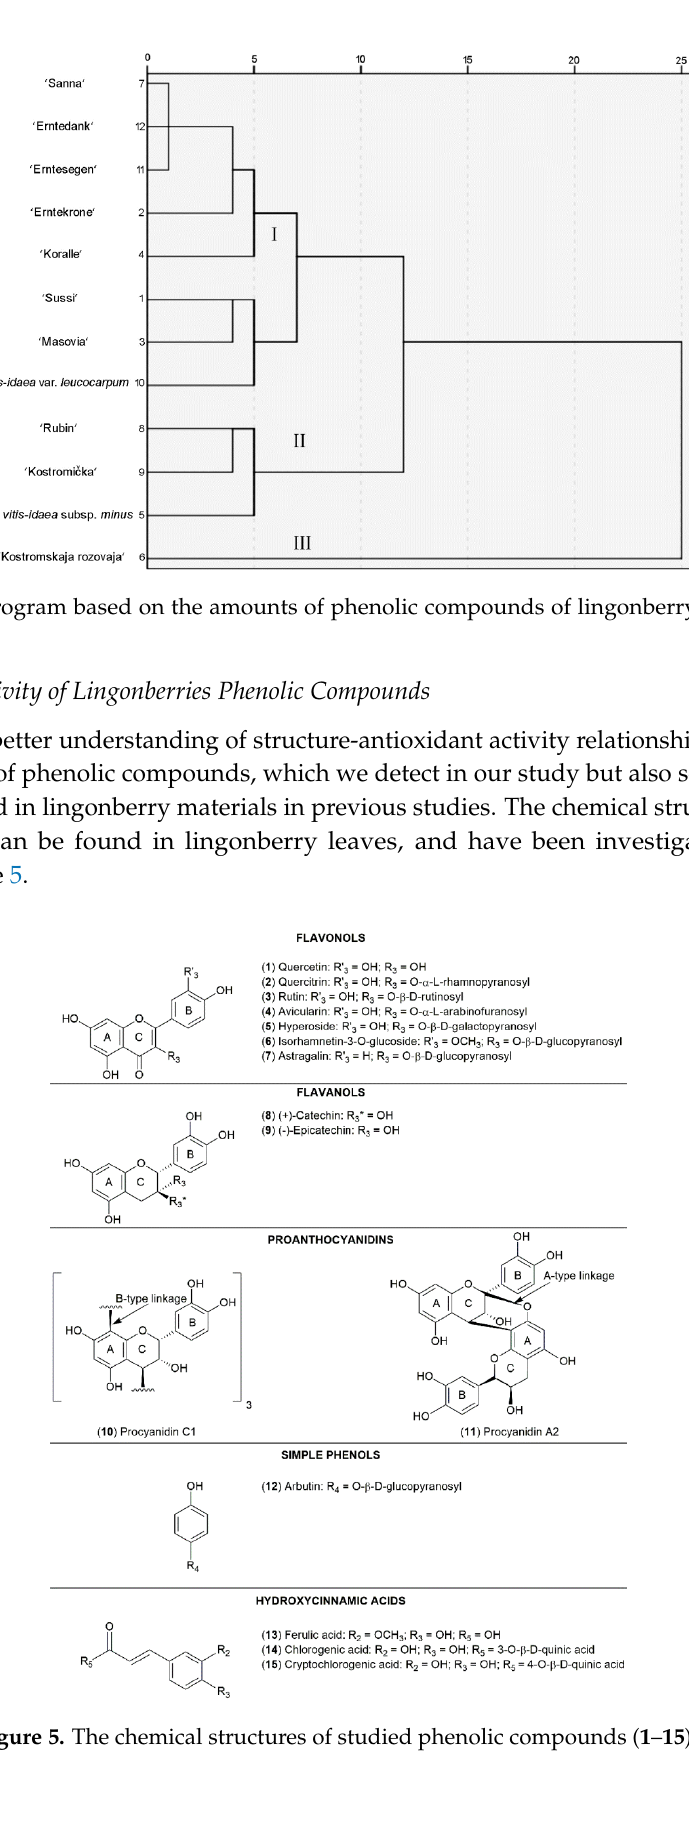
Table 3. Calibration curves (y = ax + b) data obtained by ABTS assay for tested compounds. Compound